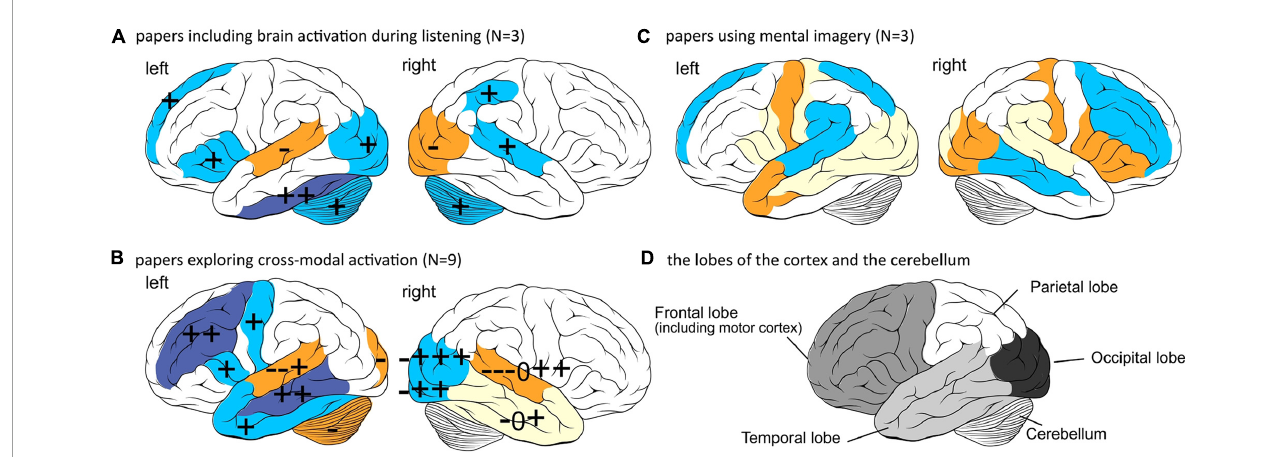
FIGURE3 Regions of the cortex found to be activated in the papers related to speech perception outcomes. +, –, and 0 indicates a positive correlation, negative correlation, or null results, respectively found in an included paper. Accuracy of the depiction depends on accuracy of the reports, neuroimaging and analysis technique used in the papers. Top: left hemisphere, Bottom: right hemisphere. (A) The parts of the cortex found to be activated during auditory perception related to speech perception outcomes. Blue areas are found to be positively correlated and orange areas negative. (B) The parts of the cortex found to be activated during auditory perception, and visual perception. Blue areas are found to be mostly positively correlated and orange areas mostly negative. Yellow areas show conflicting results. The right amygdala (+), cingulate sulcus (+) and bilateral thalami (–) are not depicted because they are not located on the outside cortex. (C) The parts of the cortex found to be activated during speech imagery tasks preoperatively. Blue areas are found to be positively correlated and orange areas negative. Yellow areas show conflicting results. Since most of this data is from the same participant group, no signs are used to indicate findings per paper. Left and right medial temporal lobes including hippocampal gyrus are not depicted because they are not located on the outside cortex. (D) The lobes of the cortex (frontal, parietal, temporal, and occipital lobe) and the cerebellum. This image can be used as a guidance to read the text and interpret part (A–C) of the figure. The outline of the brain was drawn by Patrick J. Lynch, medical illustrator and C. Carl Jaffe, MD, cardiologist, https://creativecommons.org/licenses/by/2.5/.